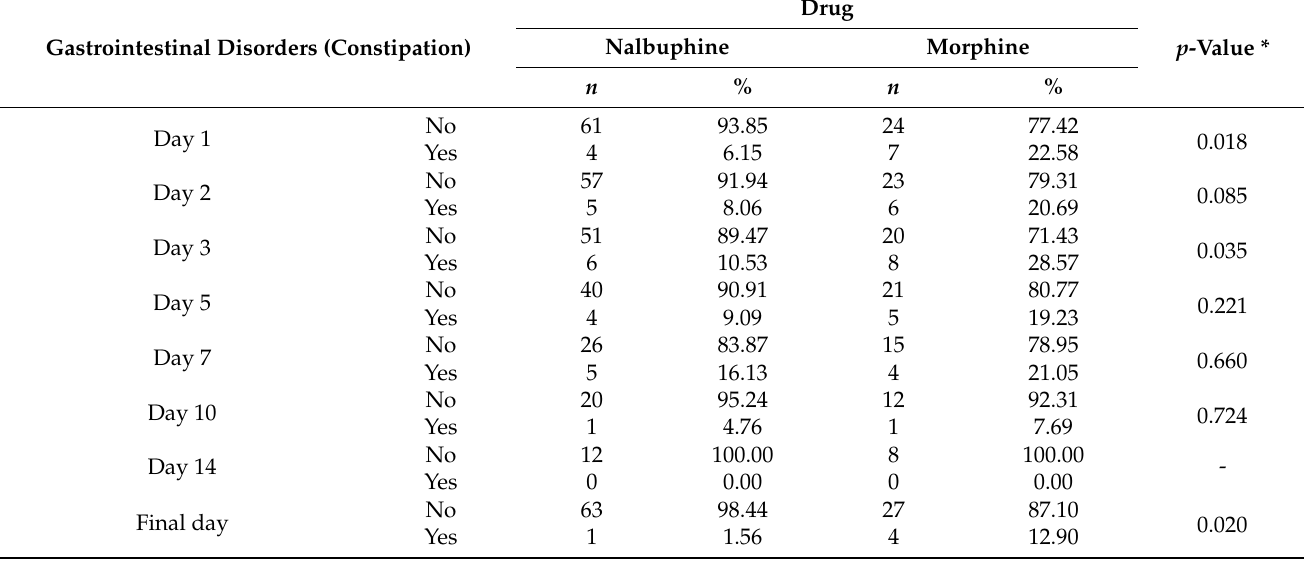
Table 3. Comparison of the incidence of constipation between patients receiving nalbuphine and morphine.